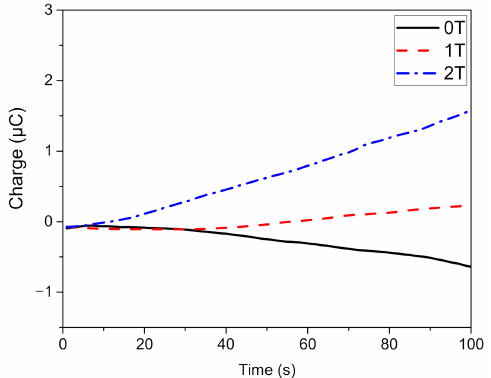
Figure 4. GF electrification curves obtained from 0T, 1T, and 2T paths at a scrolling velocity equal to 2.8